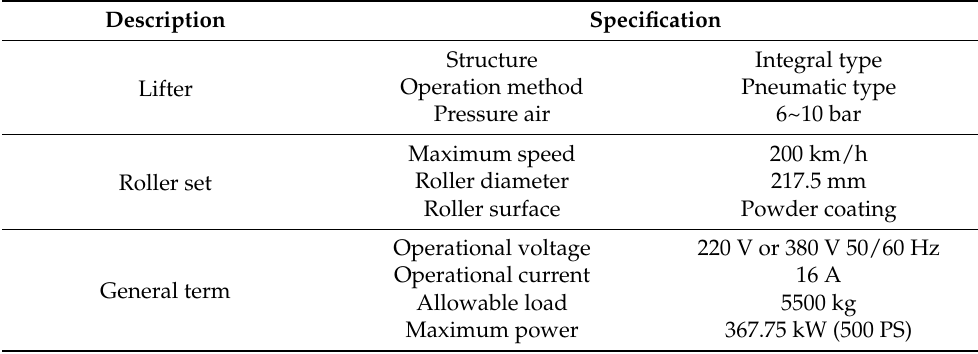
Table 3. Specifications of chassis dynamometer.